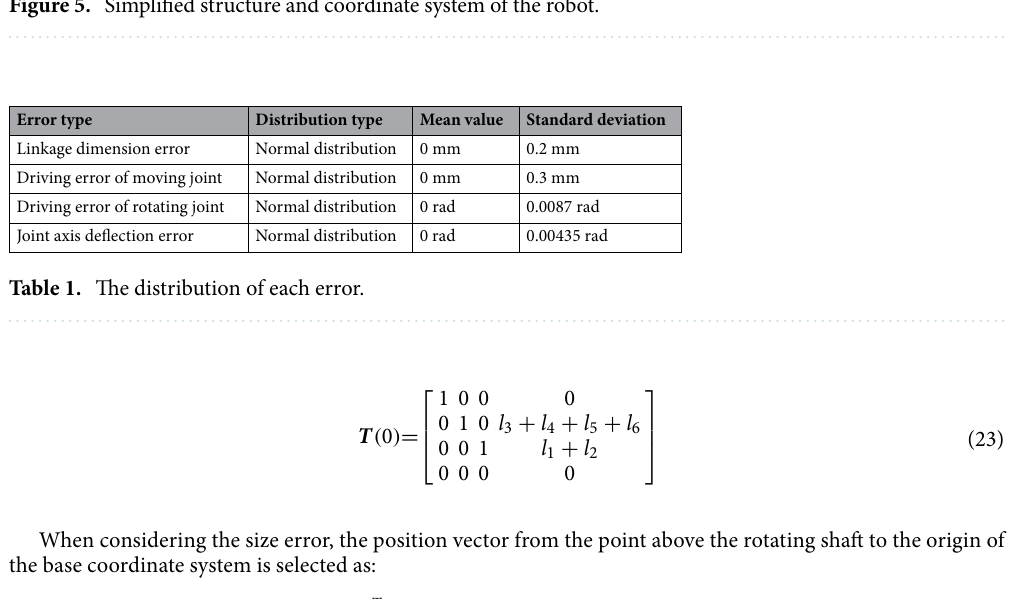
Figure 5. Simplified structure and coordinate system of the robot.